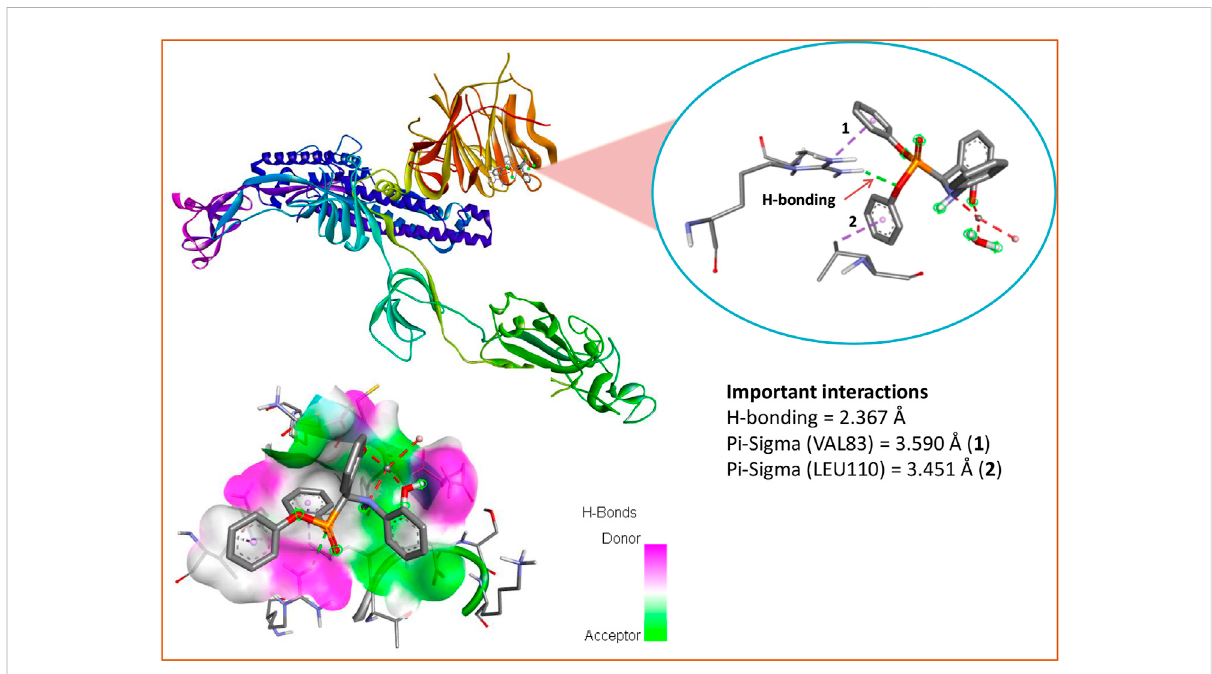
FIGURE 7 Molecular docking study of species I with the SARS-CoV-2 Omicron variant protease